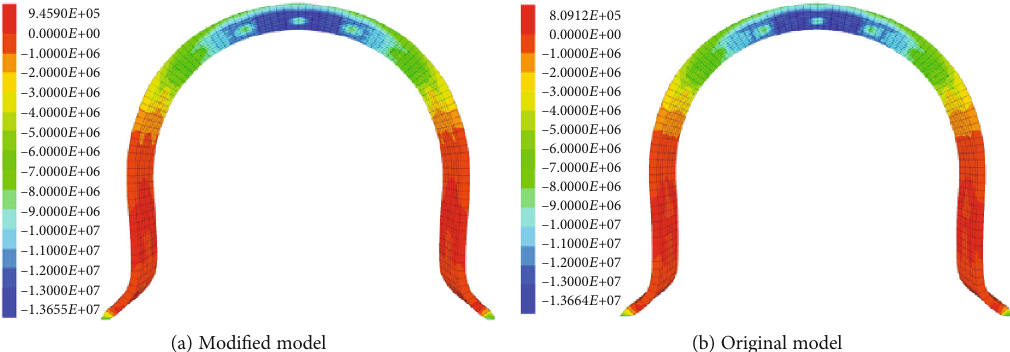
Figure 16: The horizontal stress contour of the sprayed layer when the modi fi ed model and the original model arrive at the calculation balance.